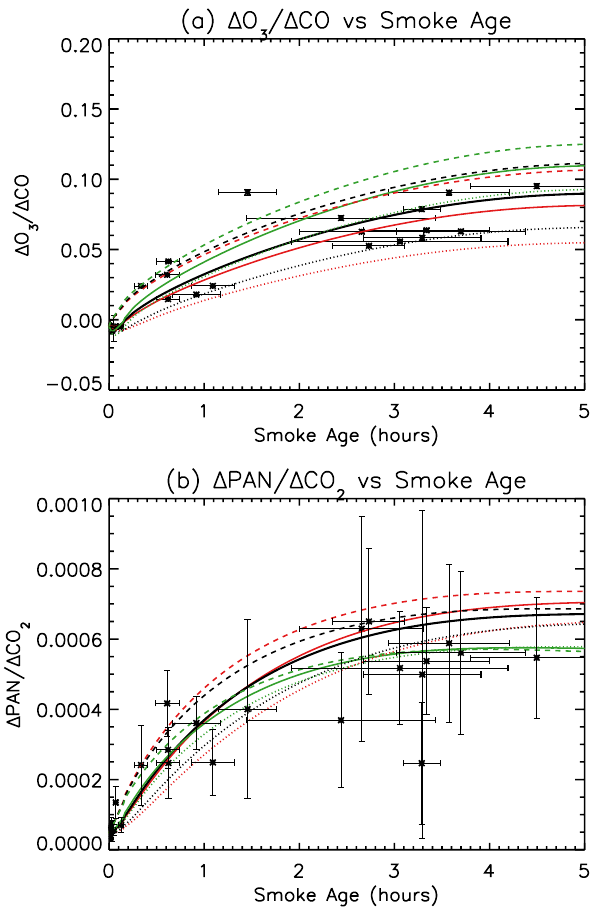
Figure 12. As in Fig. 6, but for the “half fragmentation” SVOC mechanism (see Table